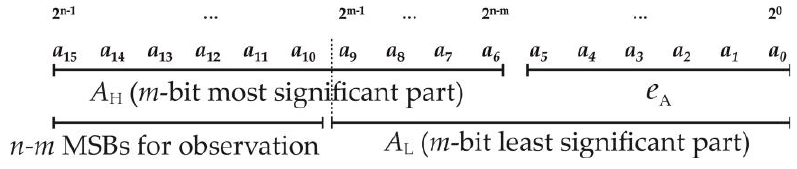
Figure 1. Segmentation of the signal A with n = 16 bits and m = 10 bits.